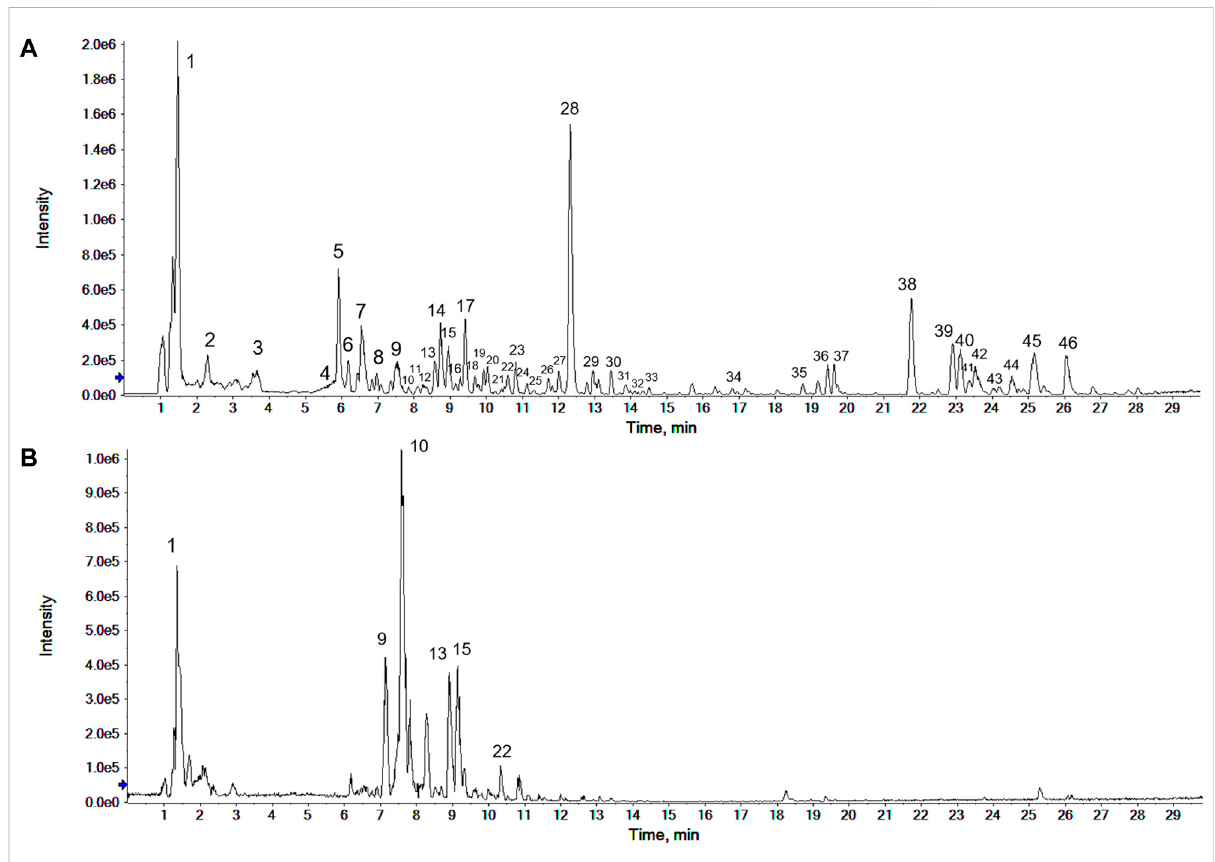
FIGURE 1 Base peak chromatogram (BPC) of CWT test solution in the positive (A) and the negative ion modes (B)